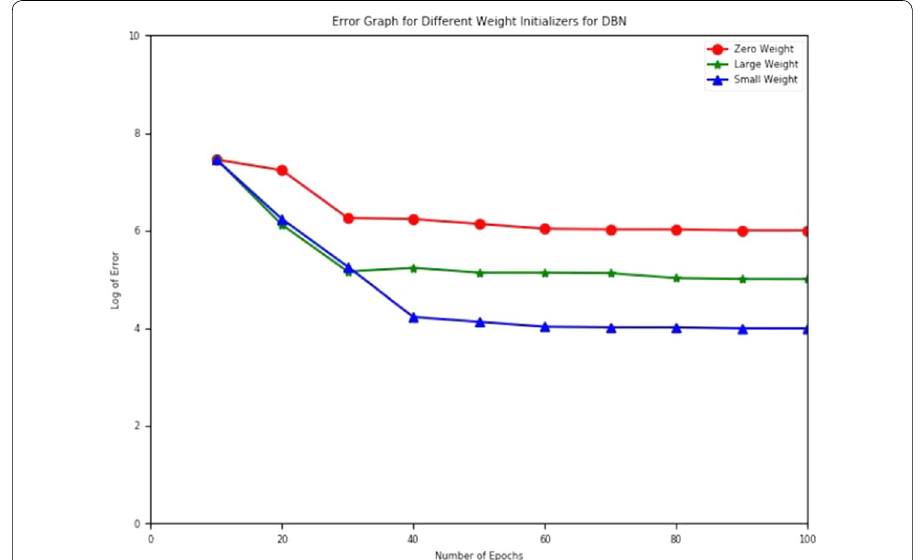
Fig. 7 Error graph for different weight initialization methods for